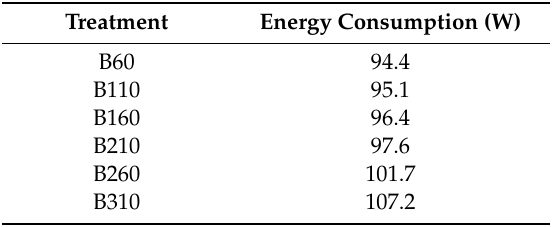
Table 5. Measured energy consumption (Watt) of the LED chambers under di ff erent blue photosynthetic flux densities (BPFD).